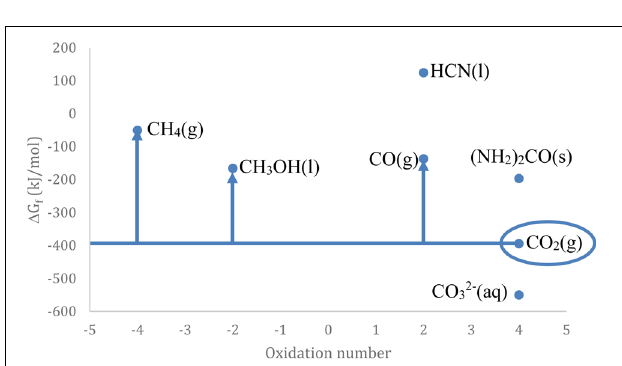
FIGURE 2 | Gibbs free energy for some C1